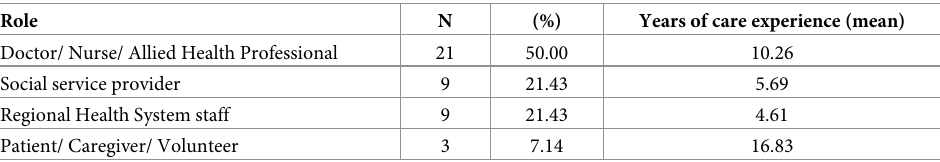
Table 1. Phase 2—Participant characteristics of interim ranking survey (n =